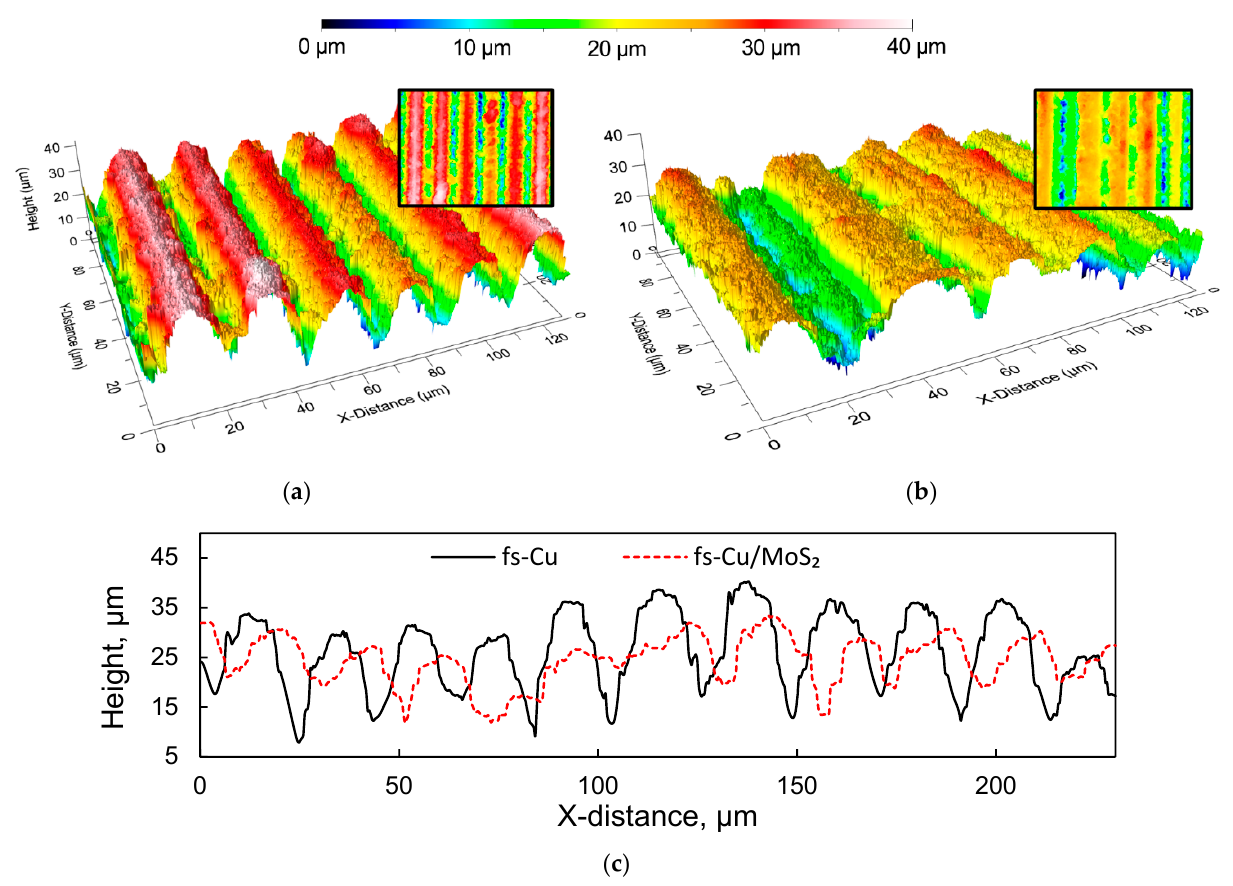
Figure 1. The 3D profilograms of the ( a ) fs-Cu surface; ( b ) a fs-Cu/MoS 2 surface; ( c ) 2D slices across the Y axis.